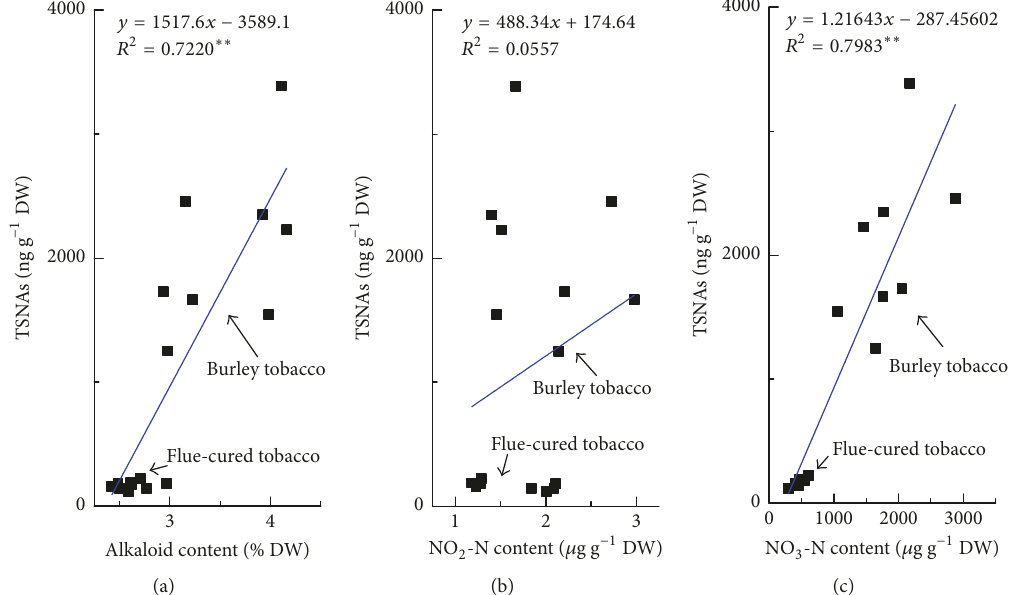
Figure 7: Correlation analysis between TSNAs, alkaloid, NO 2 -N, and NO 3 -N in tobacco. Symbol ∗∗ indicates significant correlation at 𝑝 < 0.01